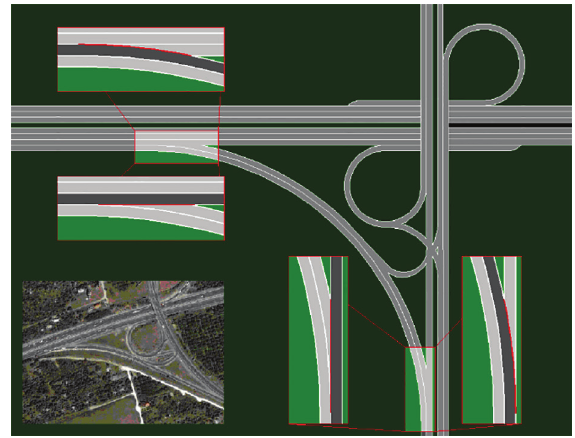
Fig. 3. Junction of common stage of M1–M7 and Egér Road (source: own